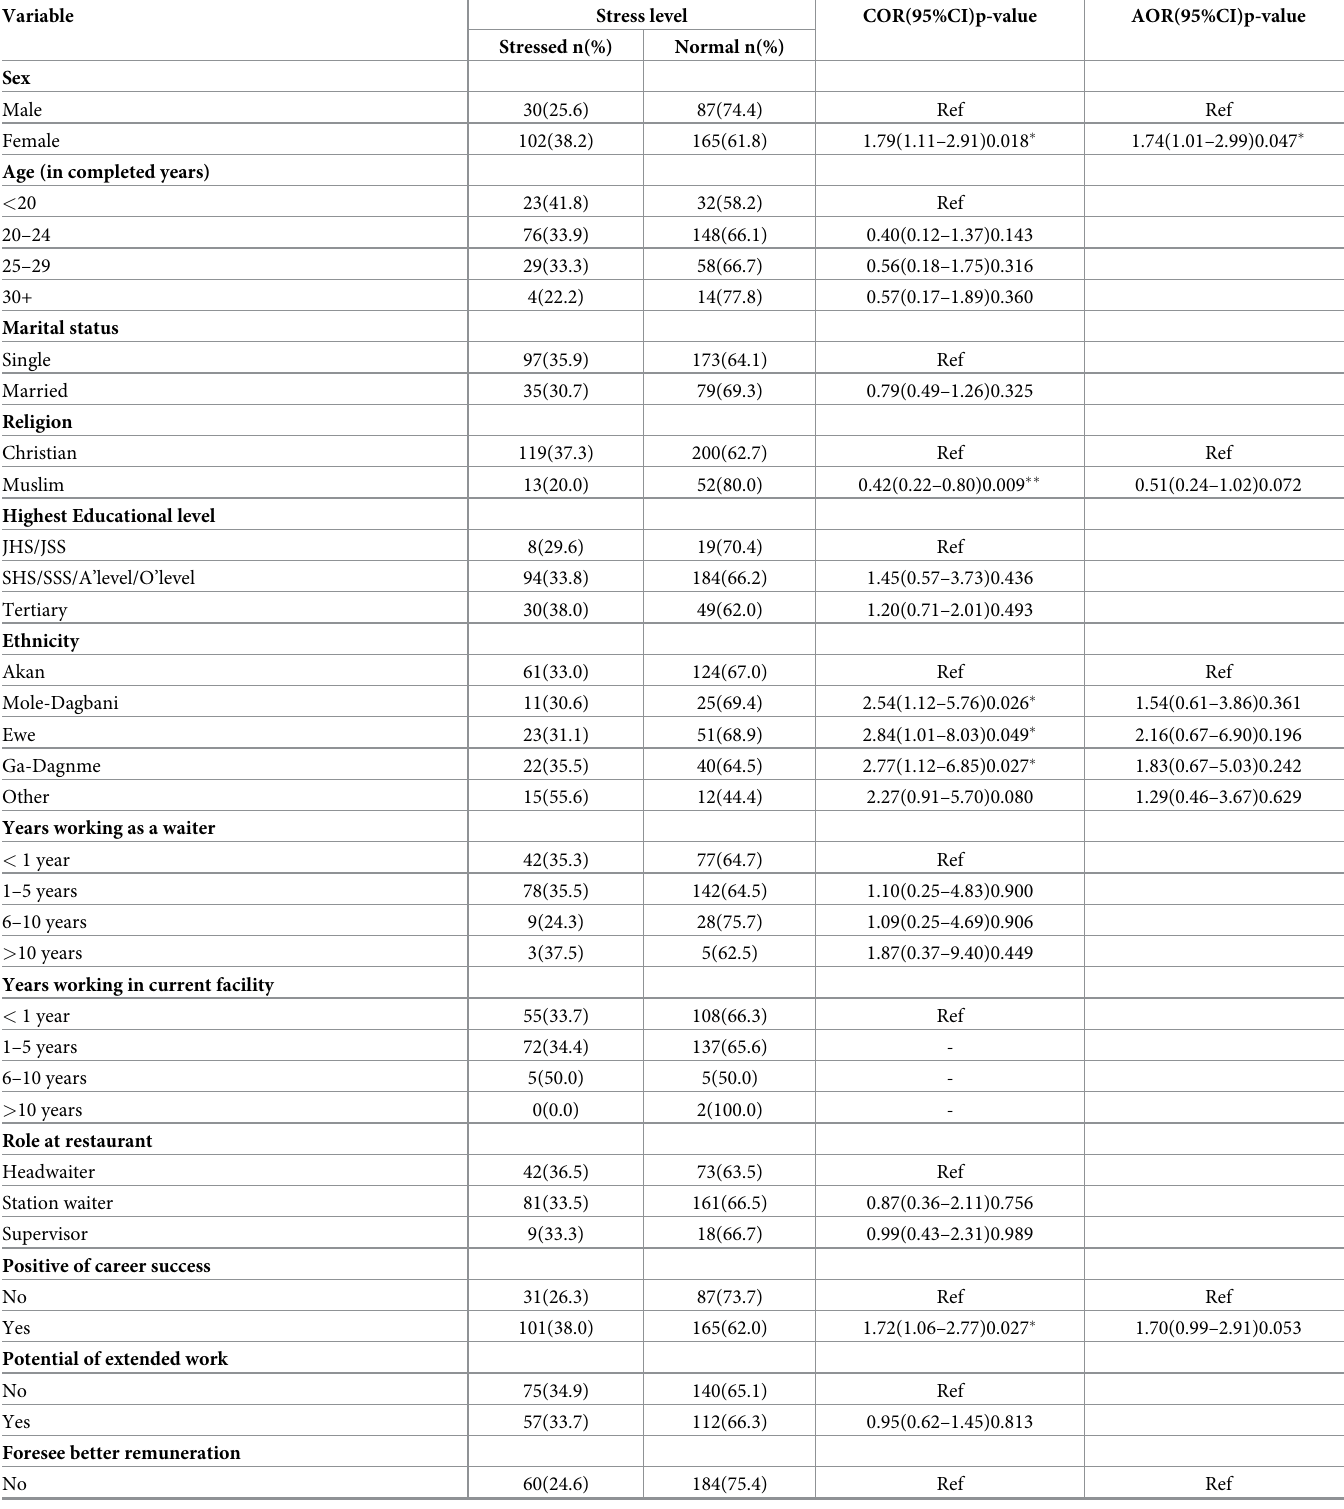
Table 6. Predictors of stress among